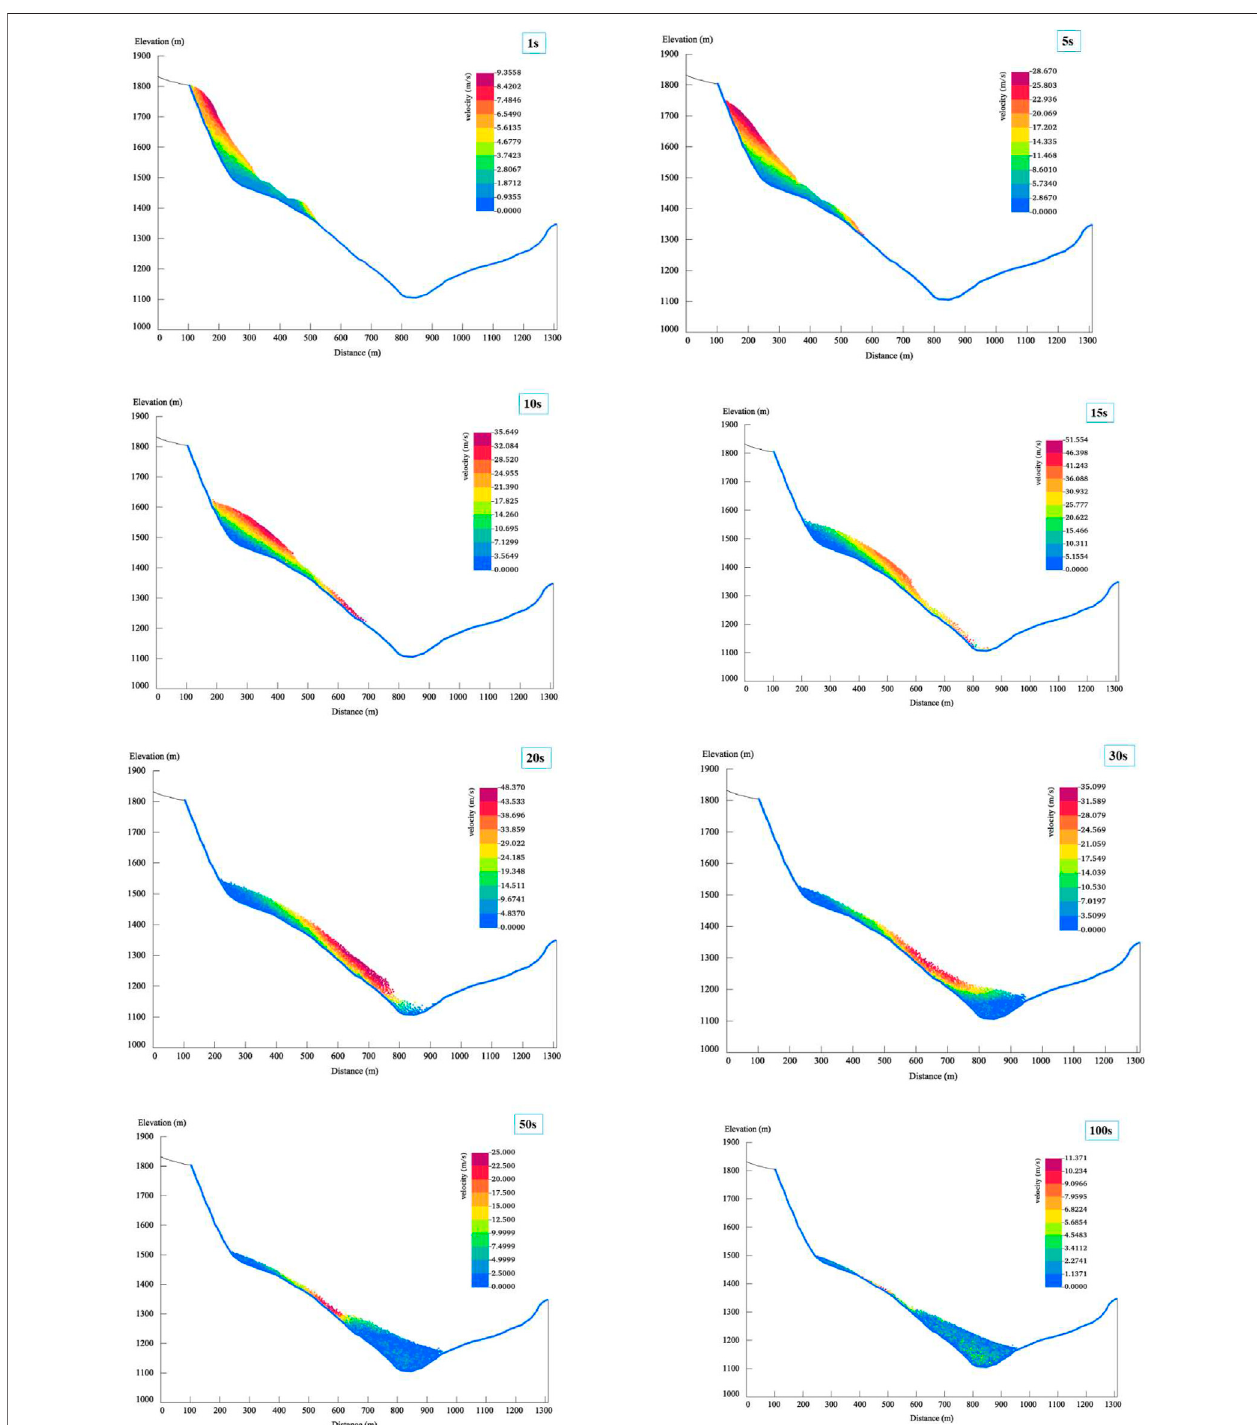
FIGURE 8 | Velocity fi eld distribution during the